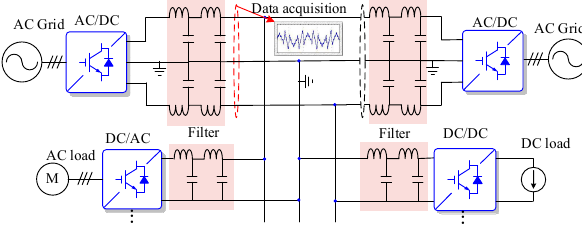
Figure 15. Schematic of a double-ended distribution model.